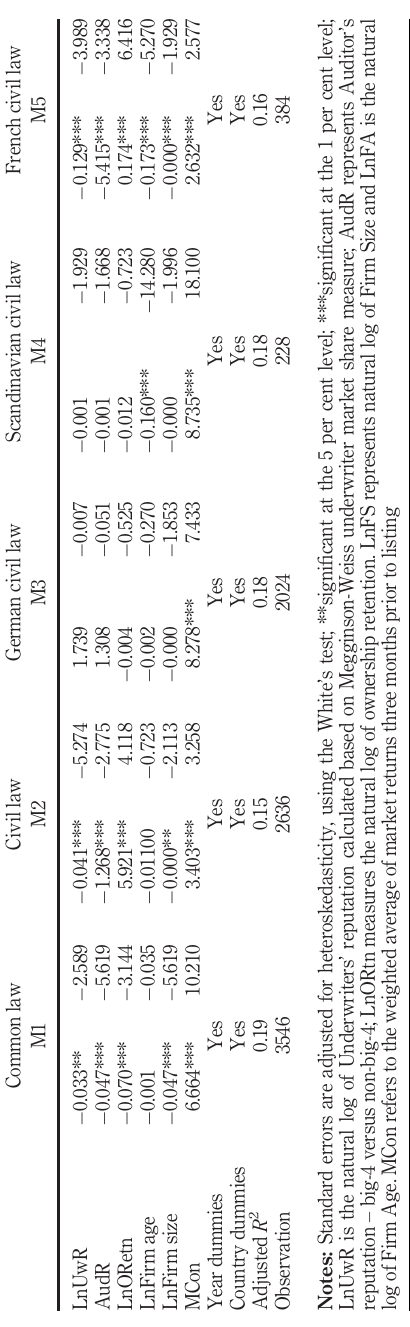
Table VII. Signaling variables and IPO initial returns in the common and civil law